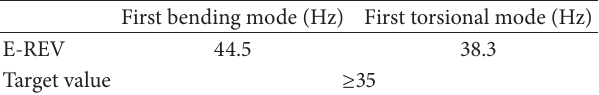
Table 2: The vehicle rigidity simulation results of E-REV before weight loss of main